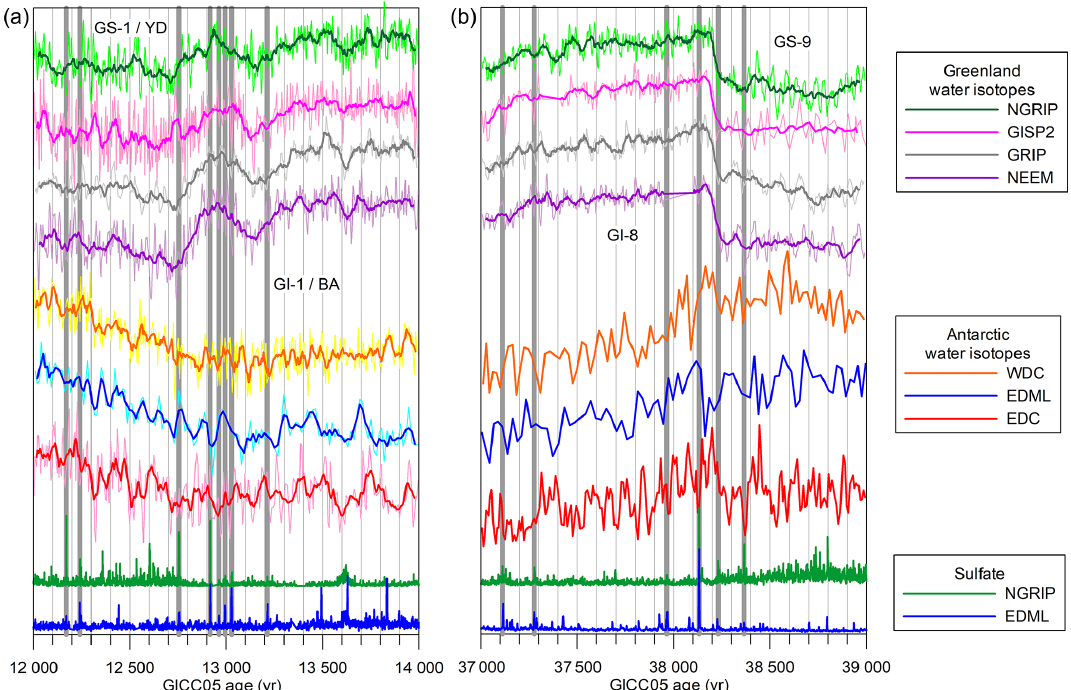
Figure 3. Synchronized climate records of the investigated ice cores across the GS-1 onset (a) and the GI-8 onset (b) applying the volcanic synchronization shown in Fig. 2. The acidity records in the bottom of the figure are for reference and are also shown in Fig. 2. All other records are δ 18 O in per mille (see Fig. 1 for scales). Grey vertical lines are bipolar volcanic match points (Table